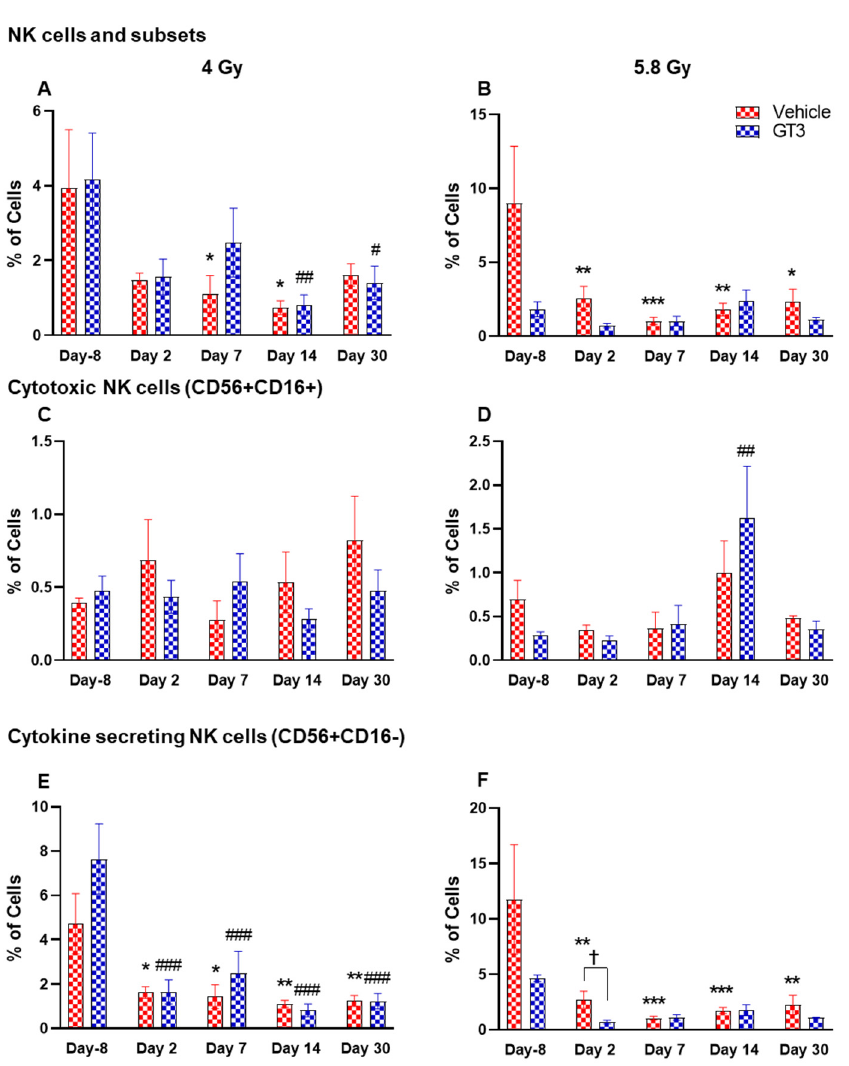
Figure 9. Effects of 4 and 5.8 Gy on NK cell ( A , B ), cytotoxic NK cell ( C , D ), and cytokine secreting NK cell ( E , F ) expression in BM of NHPs. NHPs received GT3 (37.5 mg/kg) or vehicle 24 h prior to irradiation (4 and 5.8 Gy). BM was collected at various time points and the expression of NK cells and their subsets were analyzed. Data are expressed as mean ± SEM. * p < 0.05, ** p < 0.01, *** p < 0.001 vs. vehicle day-8; # p < 0.05 ## p < 0.01 ### p < 0.001 vs. GT3 day -8. p < 0.05, Vehicle vs. GT3 at day 2.